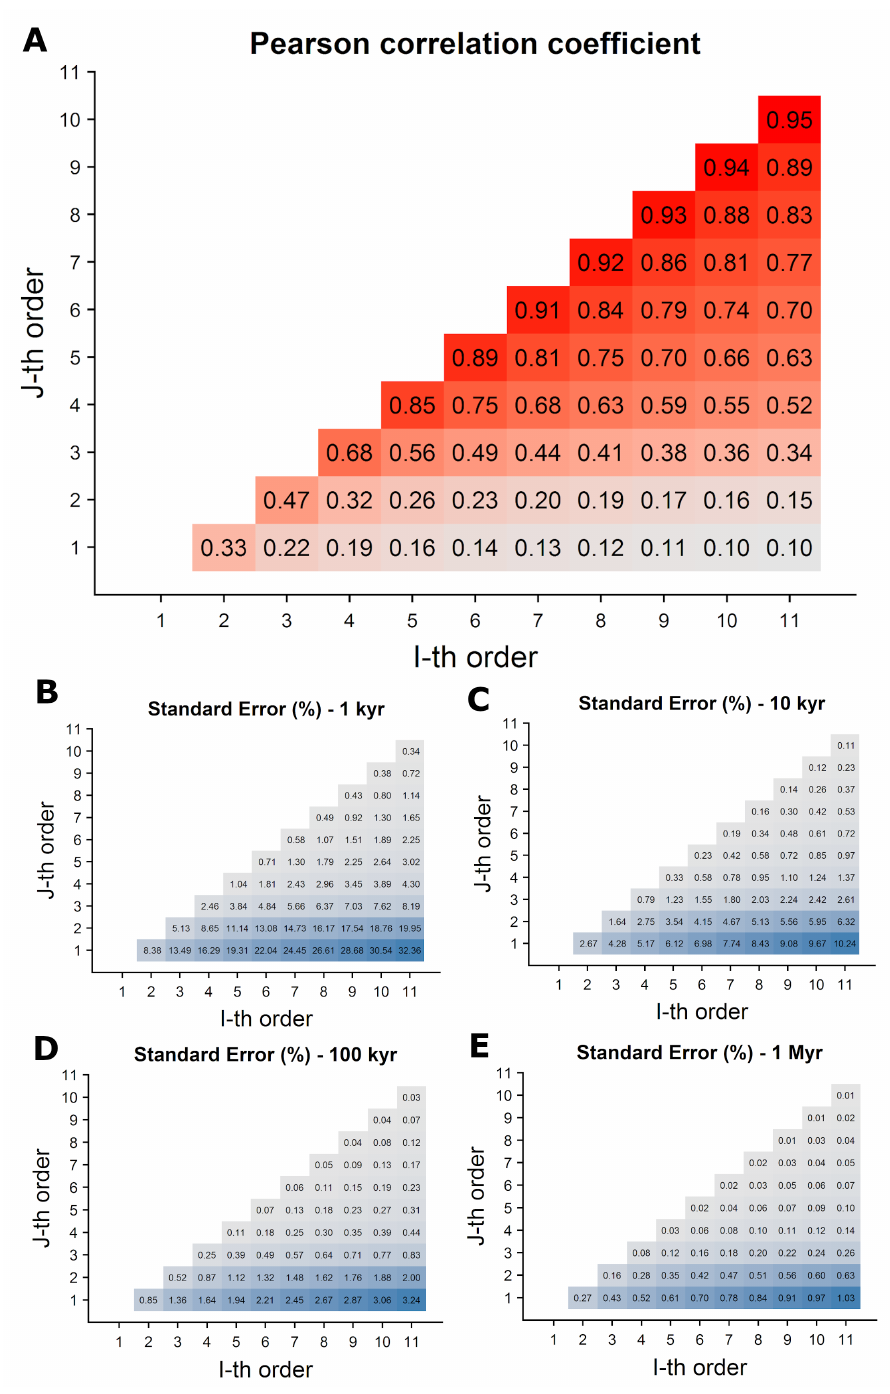
Figure 7. ( Panel A ) displays the pre-catXL correlation structure across the occurrence losses up to order M = 11. The ( Panels B – E ) depict the convergence error estimates for S = 1 K , S = 10 K , S = 100 K and S = 1 M